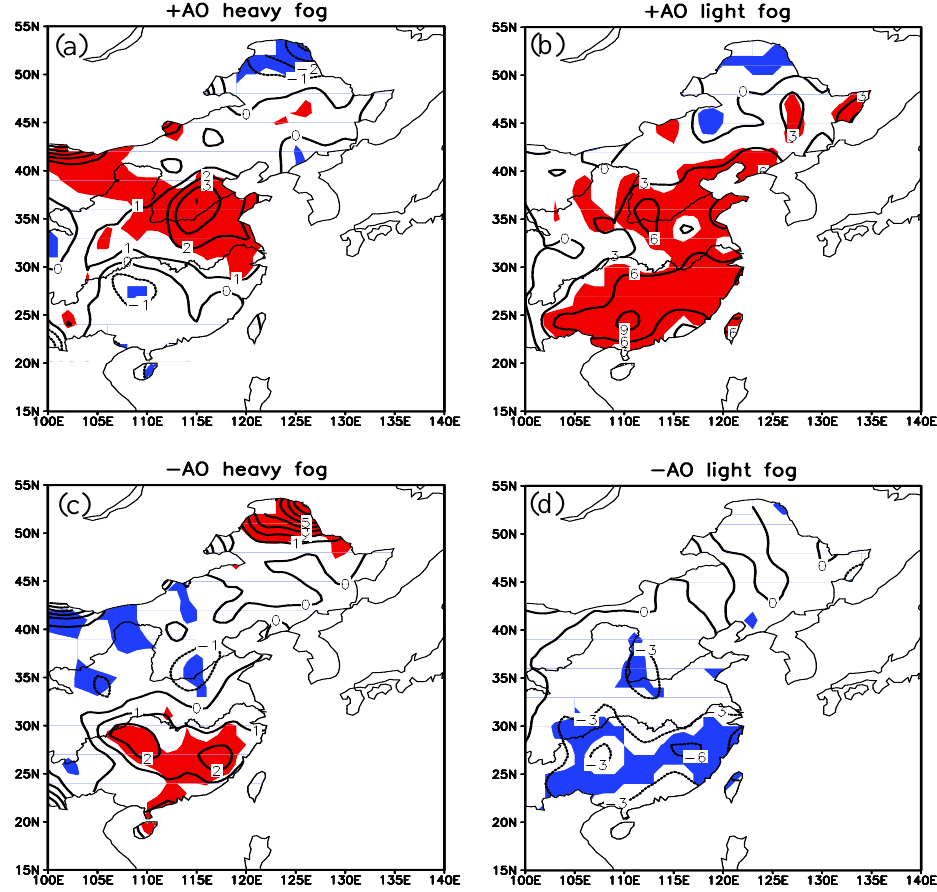
Figure 4. Anomaly of winter fog days in eastern China with positive and negative anomalies of the AO index. ( a ) +AO heavy fog, ( b ) +AO light fog, ( c ) −AO heavy fog and ( d ) −AO light fog (unit: day). Shading represents the values above the 90% confidence level.